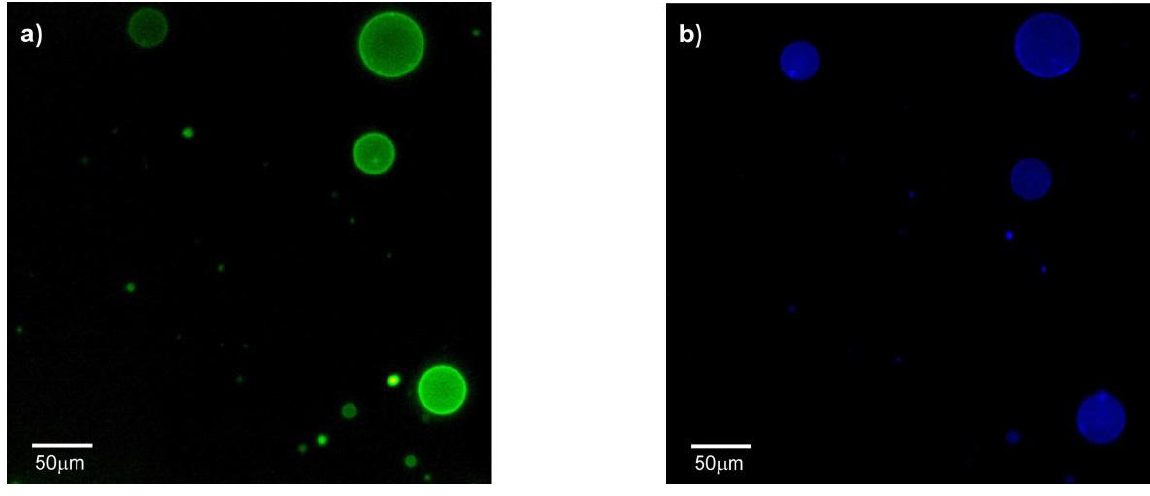
Figure 6. Fluorescence microscopy images of GUVs composed of DOPC labelled with BODIPY-PC, recorded upon irradiation with ( a ) visible- and ( b ) UV-light, after addition of